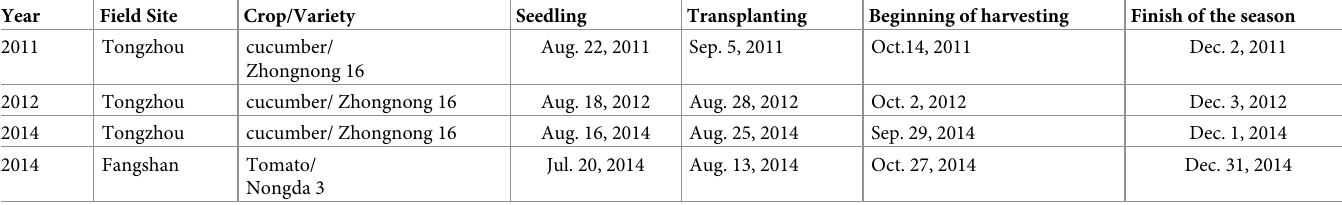
Table 2. Variety and growth calendar of the